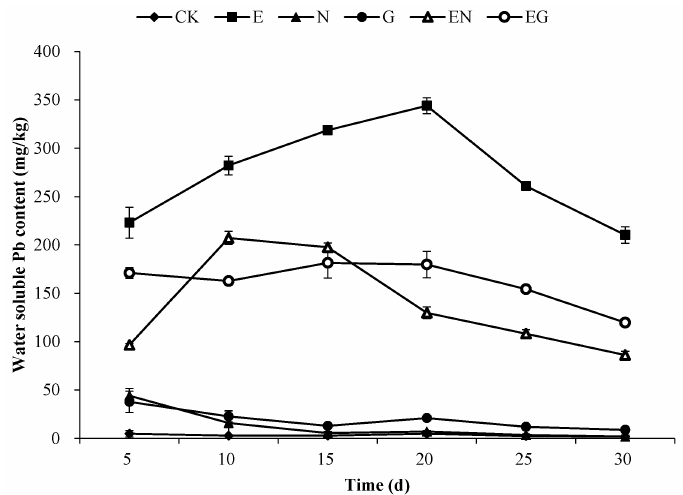
Figure 3. Changes in the soil water-soluble Pb content over 30 days.